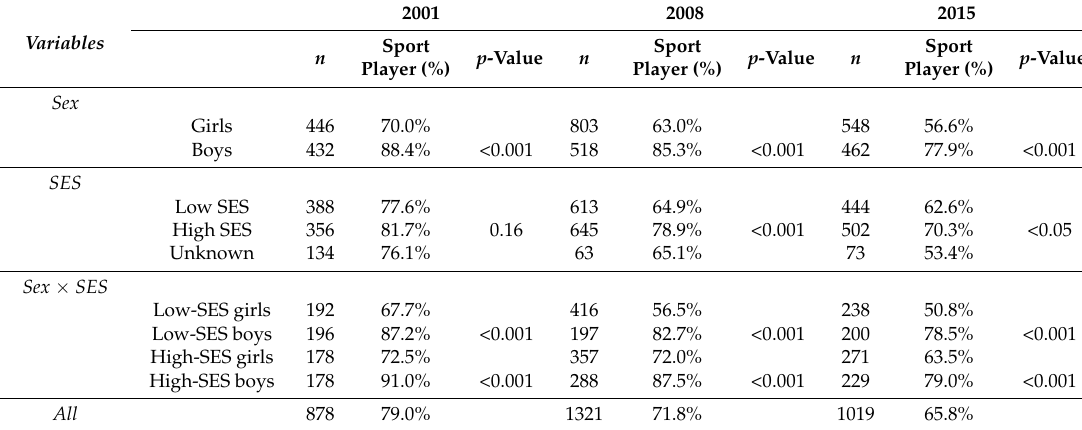
Table 1. Sociodemographic characteristics and sport participation (%) by sex, socioeconomic status (SES), and